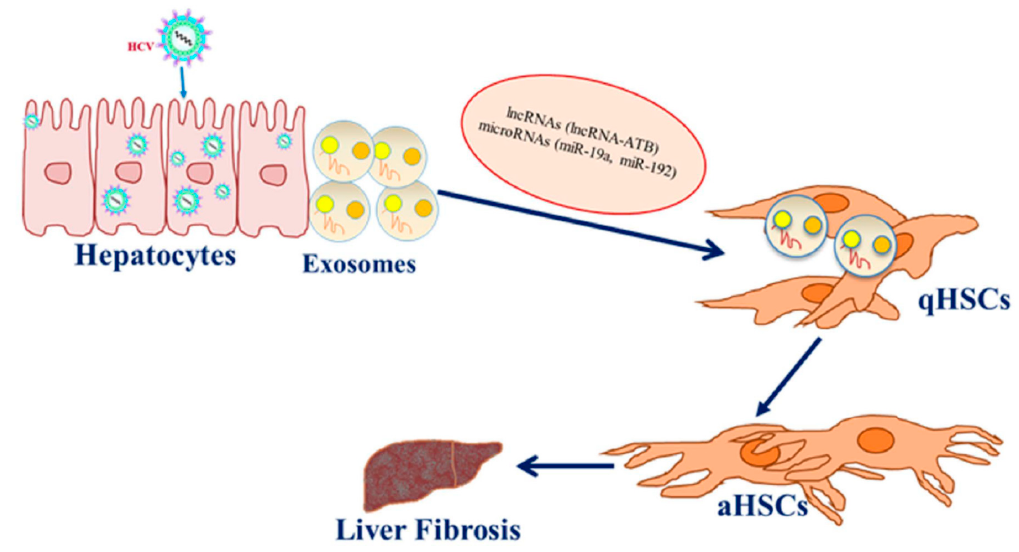
Figure 1. Exosomes carrying microRNAs and long non-coding RNAs (lncRNAs) released from hepatitis C virus (HCV)-infected hepatocytes enter into quiescent hepatic stellate cells (qHSCs) and activate hepatic stellate cells (aHSCs). This phenomenon triggers aHSCs towards liver fibrosis.